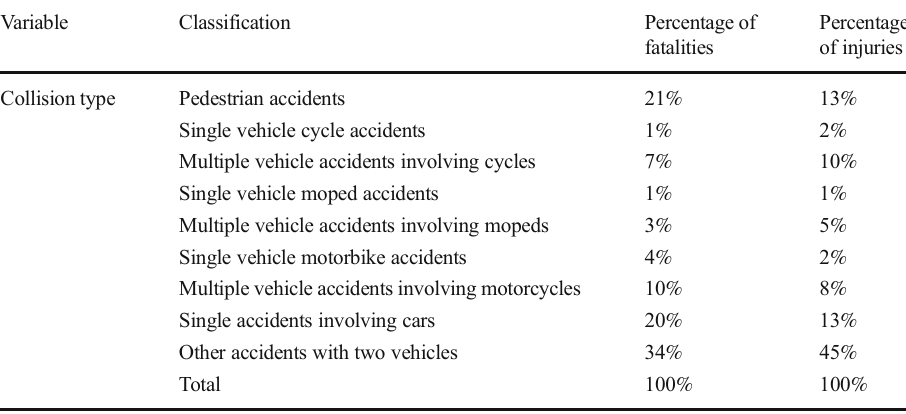
Table 3 Distribution of fatalities and injuries by collision